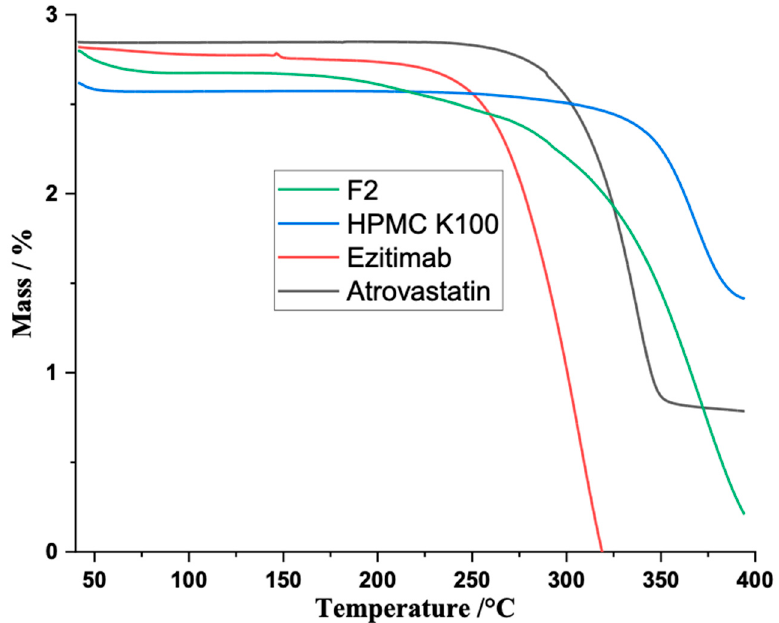
Figure 4. TGA of atorvastatin (A), ezetimibe (B), HPMC K-100 (C) and formulation F2 (D).